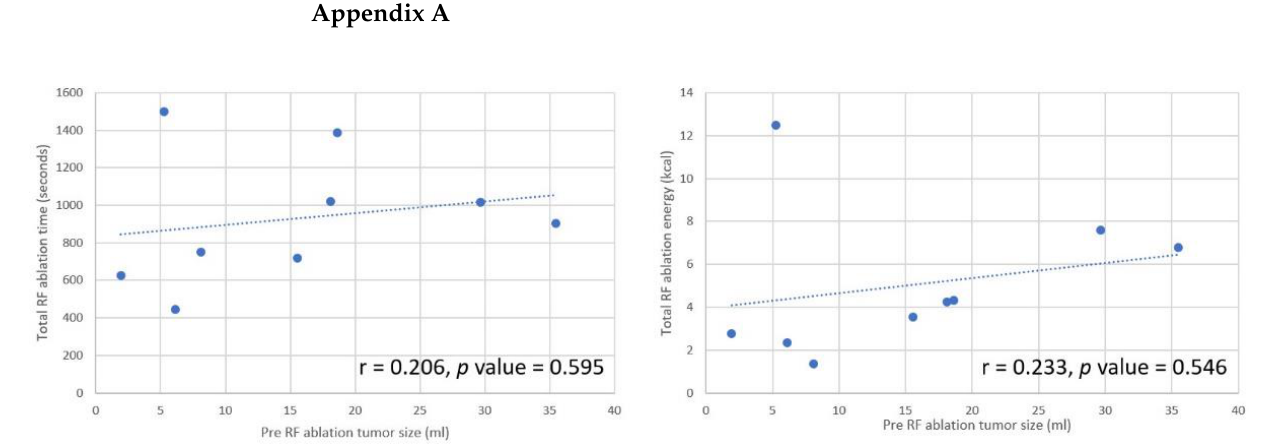
Figure A1. Radiofrequency time and energy had weak positive correlation with tumor size.